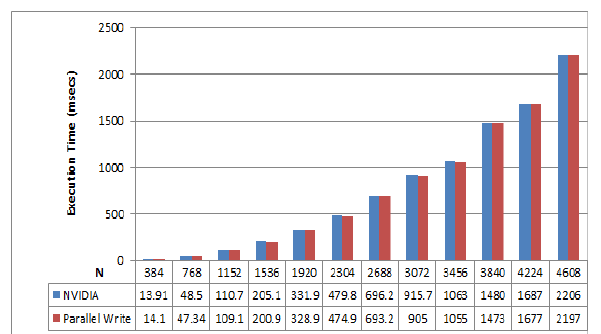
Figure 7: Exec. time with Tile Size = 16 x 16 and Thread Block Size = 16 x 16